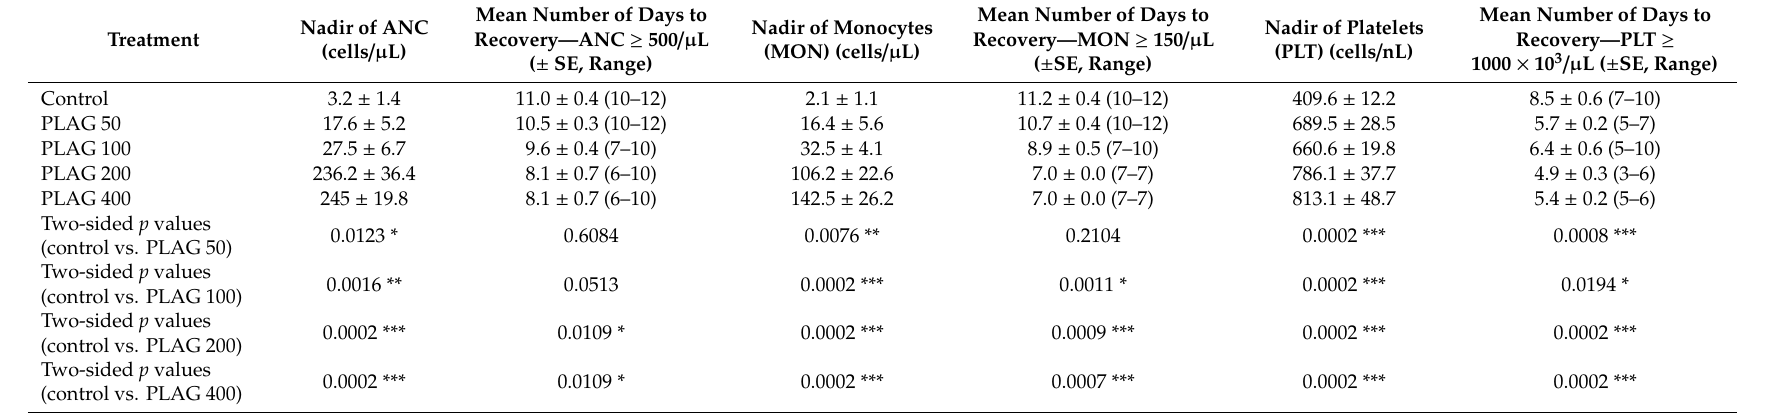
Table 3. Mean nadir and mean number of days to recovery of ANC, peripheral monocytes, and platelets in control and PLAG-treated mice injected with 5-FU (100 mg /